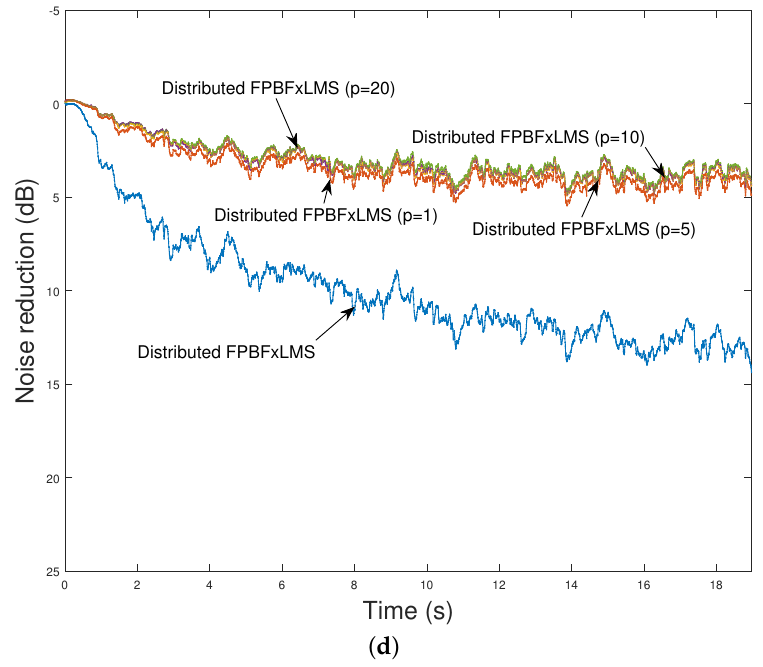
Figure 9. Noise reduction obtained for the distributed FPBPxLMS algorithm using a four-node ASN for different latency values at the node with the best performance ( a ) (case 1) ( c ) (case 2) and with the worst performance ( b ) (case 1) ( d ) (case